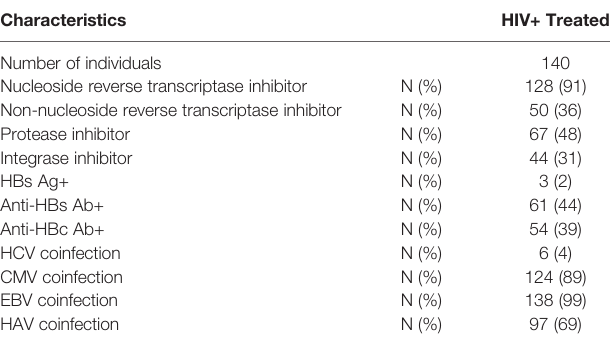
TABLE 1 | Bioclinical characteristics of the study population.